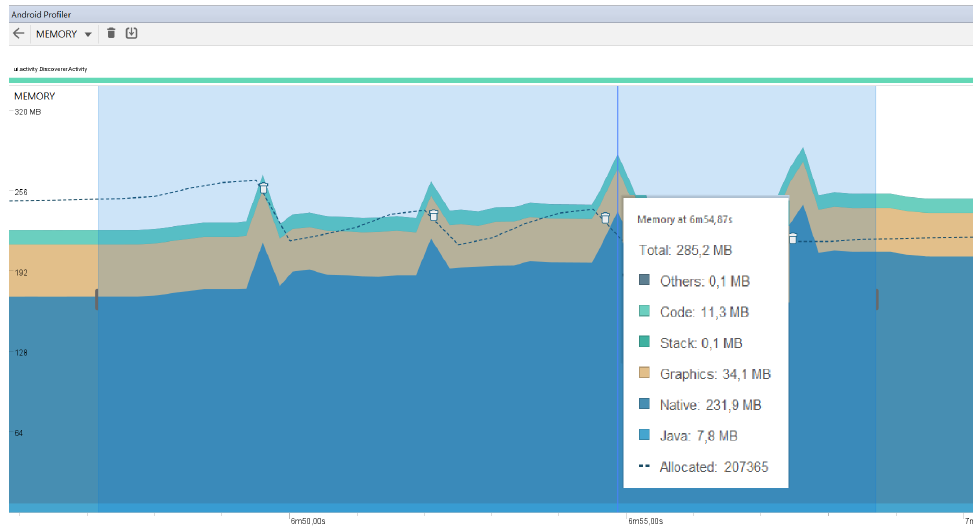
Figure 5. Doctor’s device memory consumption.